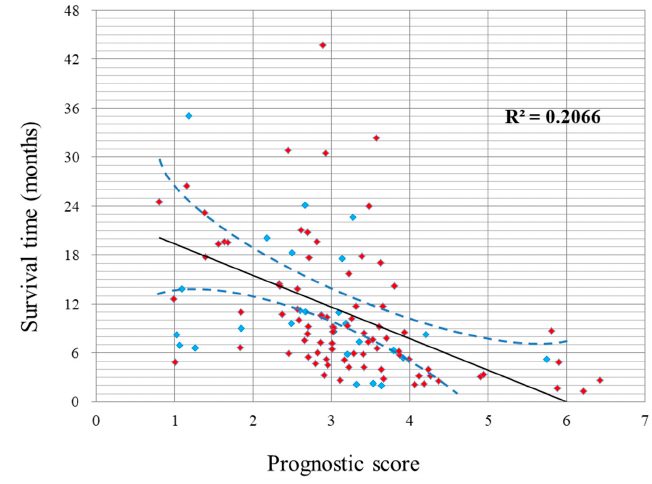
Figure 2. Scatter plot showing a linear correlation between prognostic score and survival time. The red color indicates the patients who died and the blue color indicates those who were alive at the end of the follow-up. The dashed line indicates the 95% confidence interval of the survival time for each score.